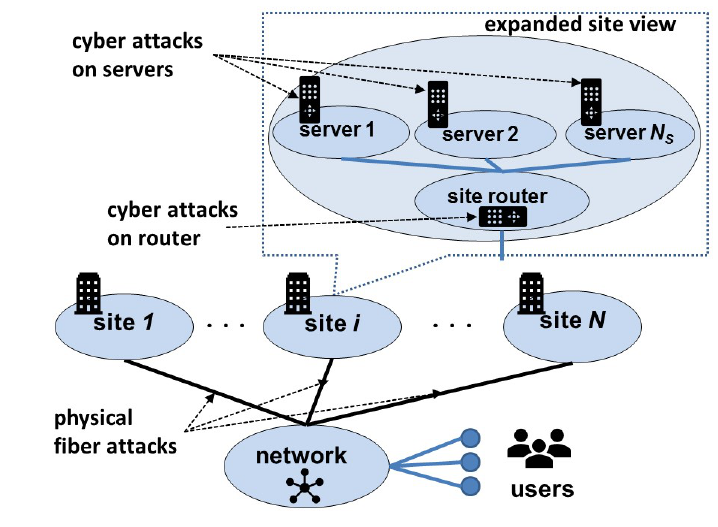
Figure 1. Cloud computing